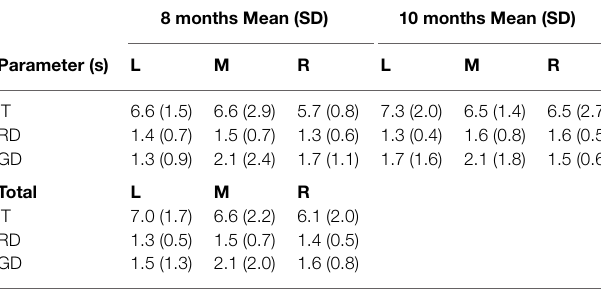
TABLE 2 | Means and standard deviations for reaching initiation time (IT), reaching duration (RD), and grasping duration (GD) in the three object